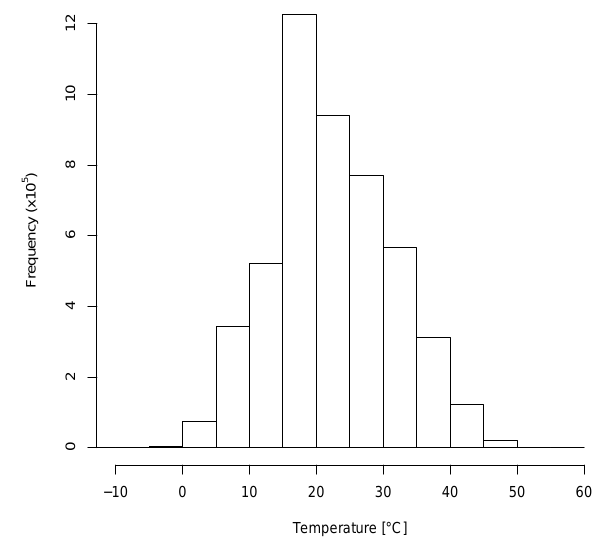
Figure 3. Temperature sensitivity of the different Brewer